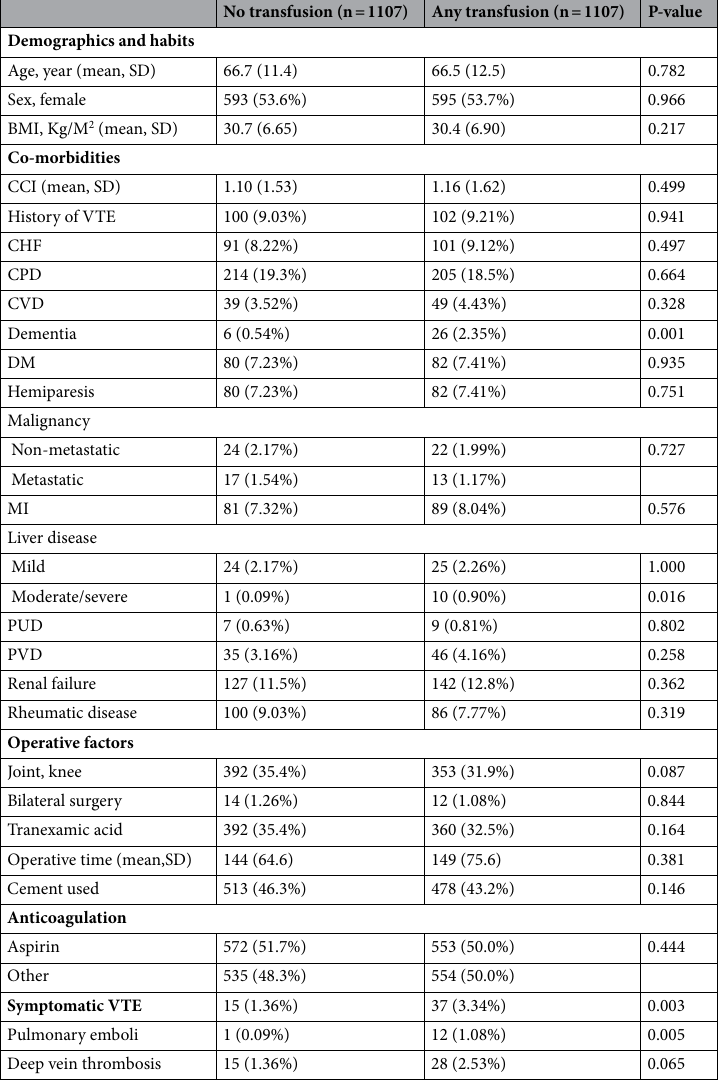
Table 6. Patient characteristics, comorbidities, operative factors and type of VTE prophylaxis for the matched revision TJA cohort and VTE rates. BMI Body Mass Index, Kg kilogram, M meter, CCI Charlson